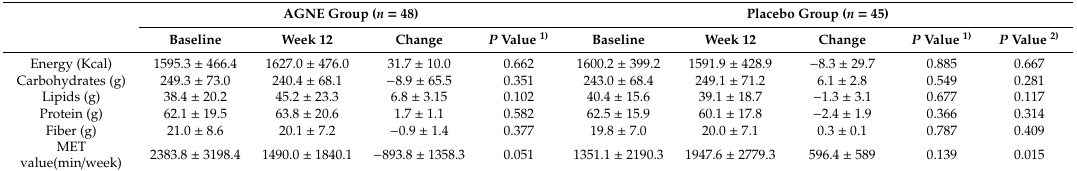
Table 3. Major nutrient intakes and metabolic equivalent values of the AGNE and placebo groups measured at baseline and 12